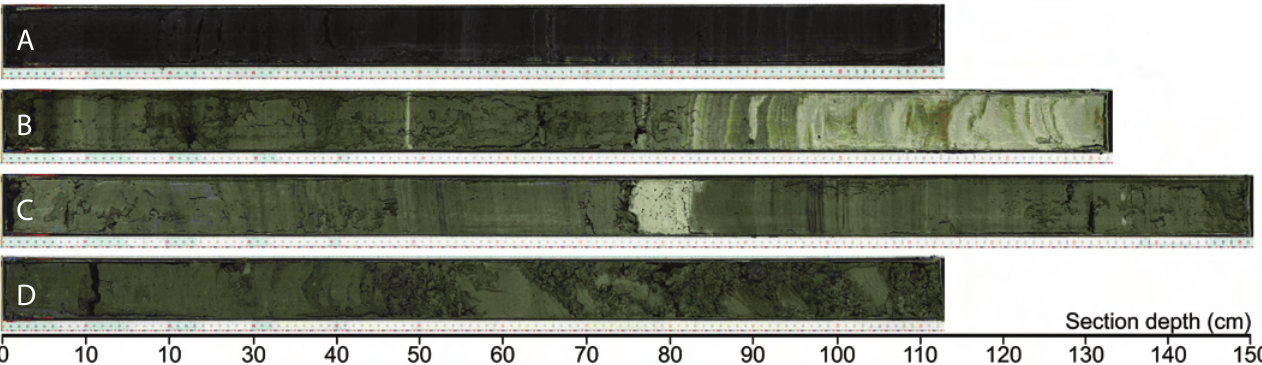
Figure 4. Selected split core sections from site PTA-2 (5022-2A). From top to bottom these represent [A] Holocene dark gray, laminated and carbonaceous silts starting from 6.39 m blf; [B] clastic and volcaniclastic, greenish-gray laminated and carbonaceous silts from 13.52 m blf; [C] clastic and volcaniclastic, greenish-gray laminated silts from 28.54 m blf; [D] clastic, greenish-gray sand and gravel from 82.52 m